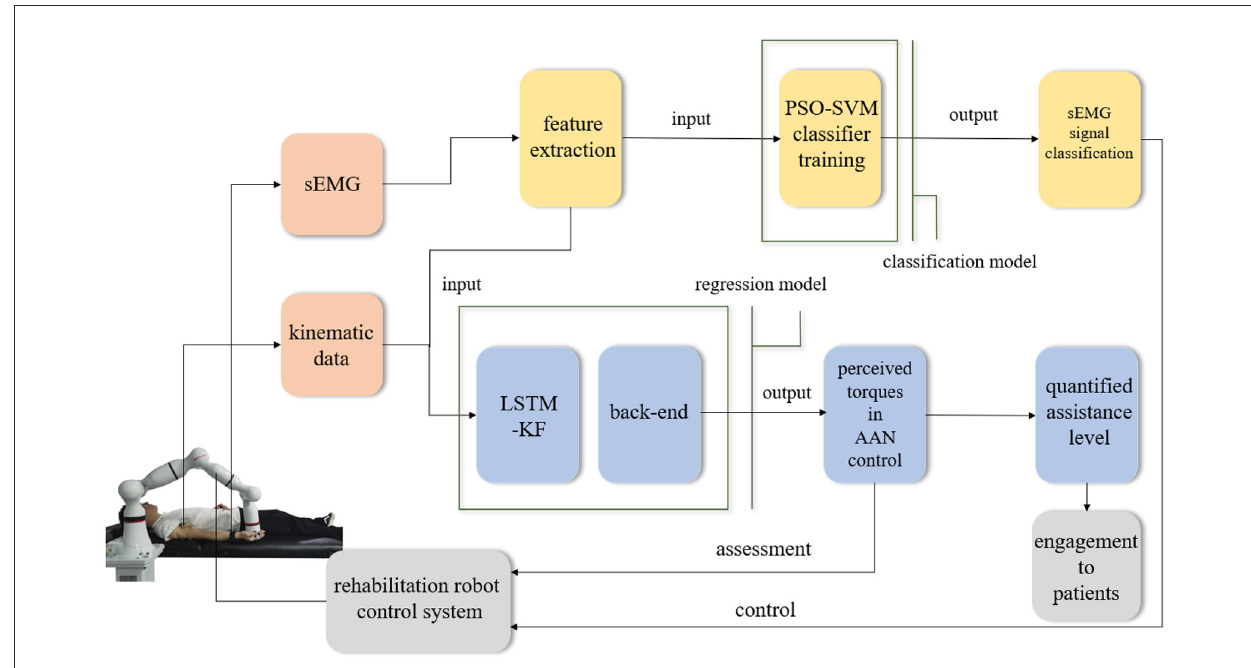
FIGURE1 The interaction process between the stroke patient and the rehabilitation robot.